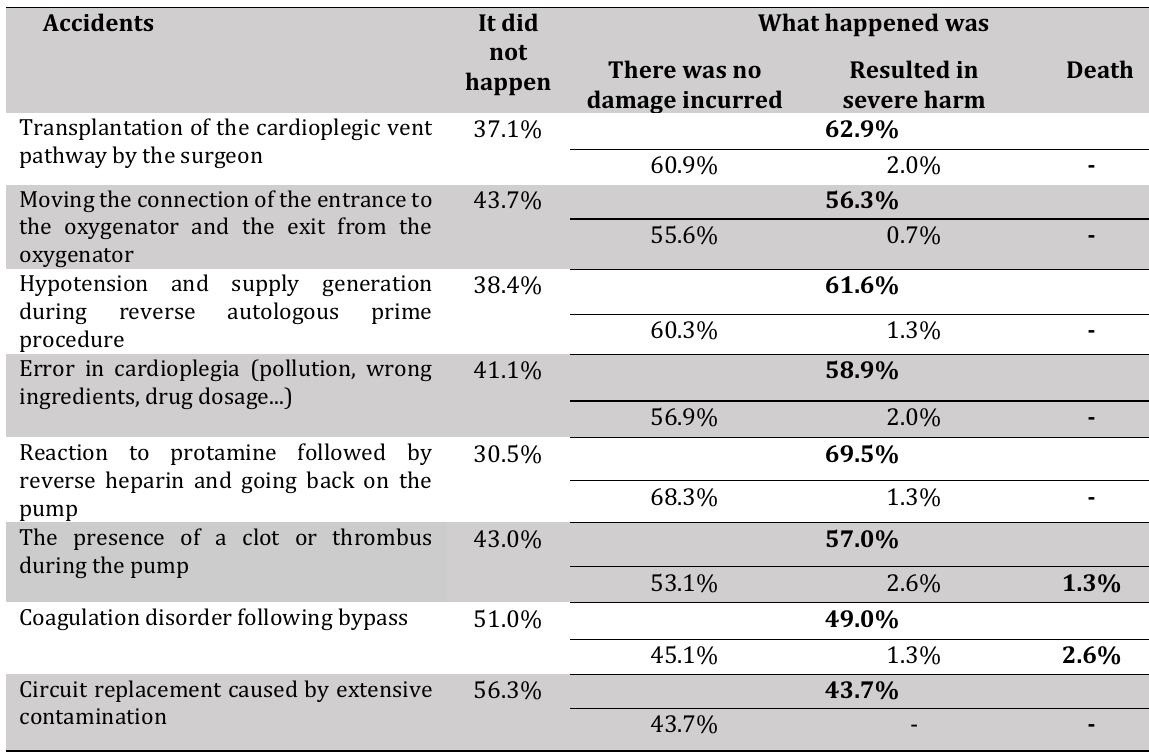
Table 3 . Cardioplegic